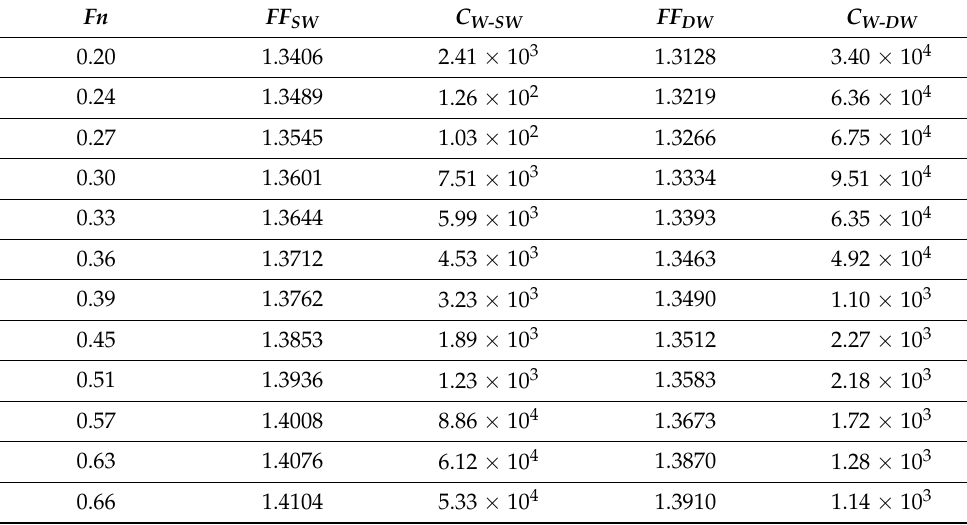
Figure 16. Wave ‐ making resistance coefficients of the catamaran. Figure 16. Wave-making resistance coefficients of the catamaran. Table 9. Wave ‐ making resistance values at LC2. Table 9. Wave-making resistance values at